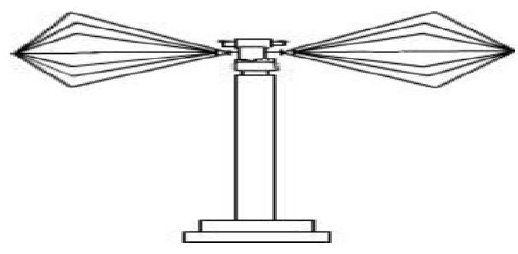
Figure 4. Biconical antenna.